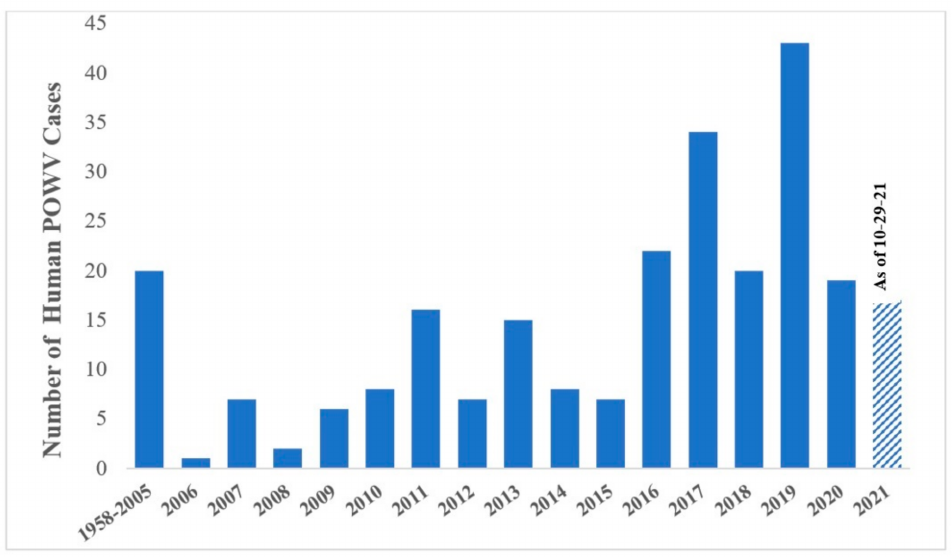
Figure 3. The number of human POWV cases reported from 1958–2021. From 1958–2005, only 20 cases were reported. From 2006–2020, an average of 14 cases a year were recorded [13,16]. Data for 2021 is represented up to 29 October